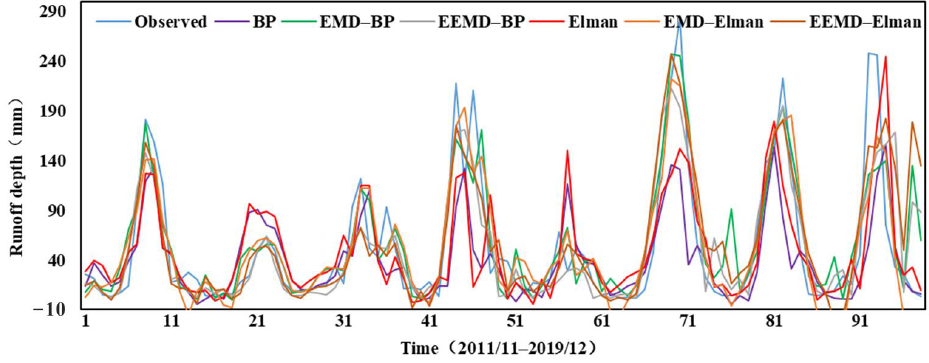
Figure 8. Forecasted and observed monthly streamflow during the validation period by Elman model, based on EMD and EEMD pre-processing techniques. ( a ) Prediction results of EMD – Elman model. ( b ) Prediction results of EEMD – Elman model. ( c ) Prediction results of EMD – Elman model, and EEMD – Elman model.